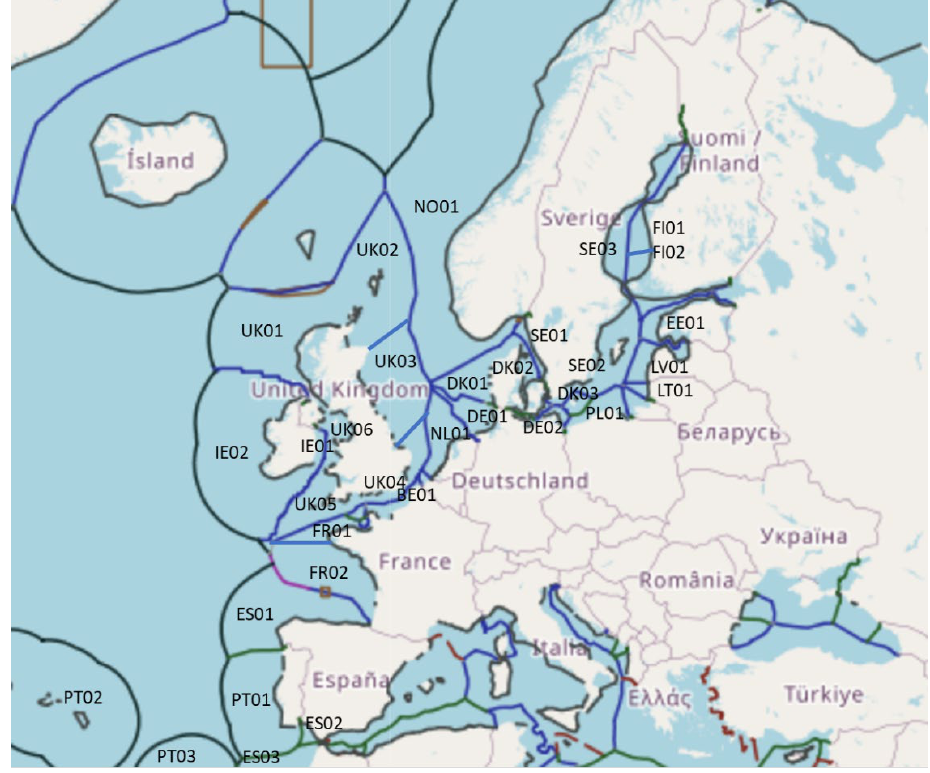
Figure 6. European water subregions. Adapted from [32].